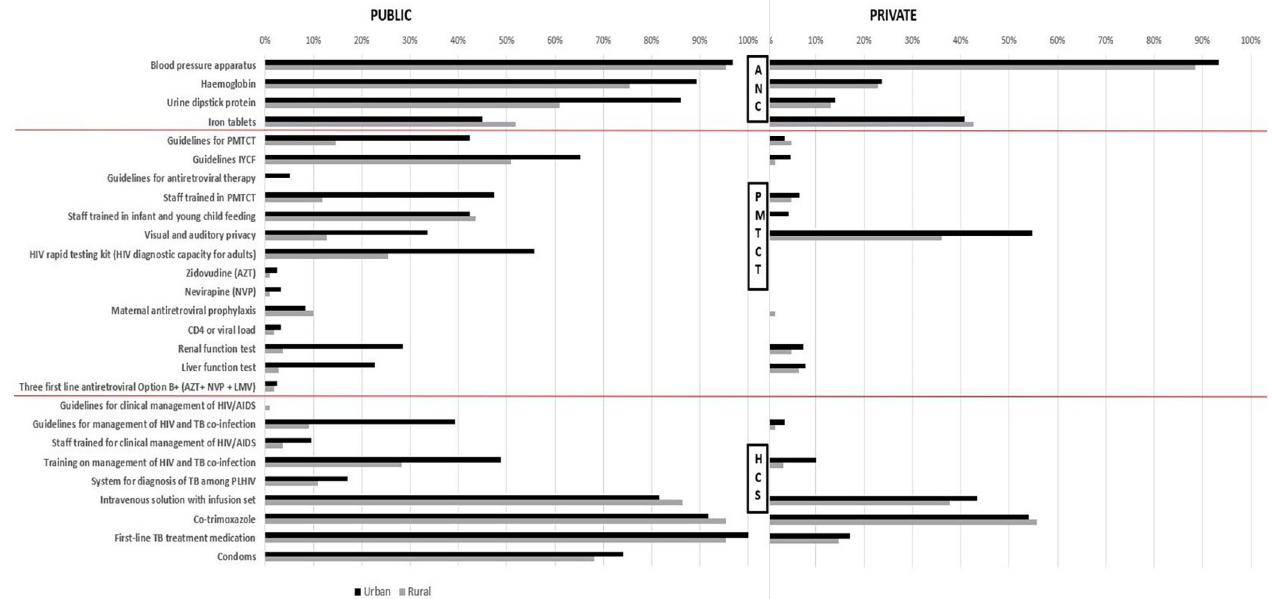
Fig 2. ANC, PMTCT and HIV Care and Support (HCS) indicators, by urban/rural and public/private, 2016. Note: Four variables in ANC service indicators are excluded from this figure since the comparable variable are not available for private facilities–these are guidelines and staff trained in ANC, and the availability of folic acid tablets and tetanus toxoid vaccine. AIDS: Autoimmune Deficiency Syndrome; ANC: Antenatal Care; AZT: Zidovudine; CD4: Cluster of Differentiation 4; HIV: Human Immunodeficiency Virus; IYCF: Infant Young and Child Feeding; LMV: Lamovudine; PLHIV: People Living with Human Immunodeficiency Virus; PMTCT: Prevention of Mother-to-Child Transmission; NVP: Nevirapine; TB: Tuberculosis.